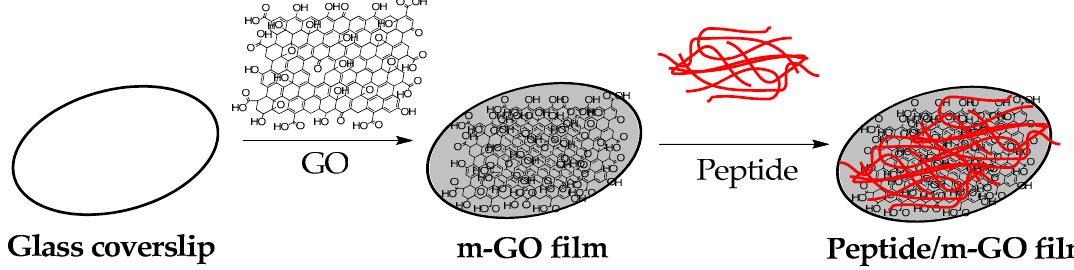
Scheme 1. Schematic illustration of the preparation of peptide conjugated on m-GO film.